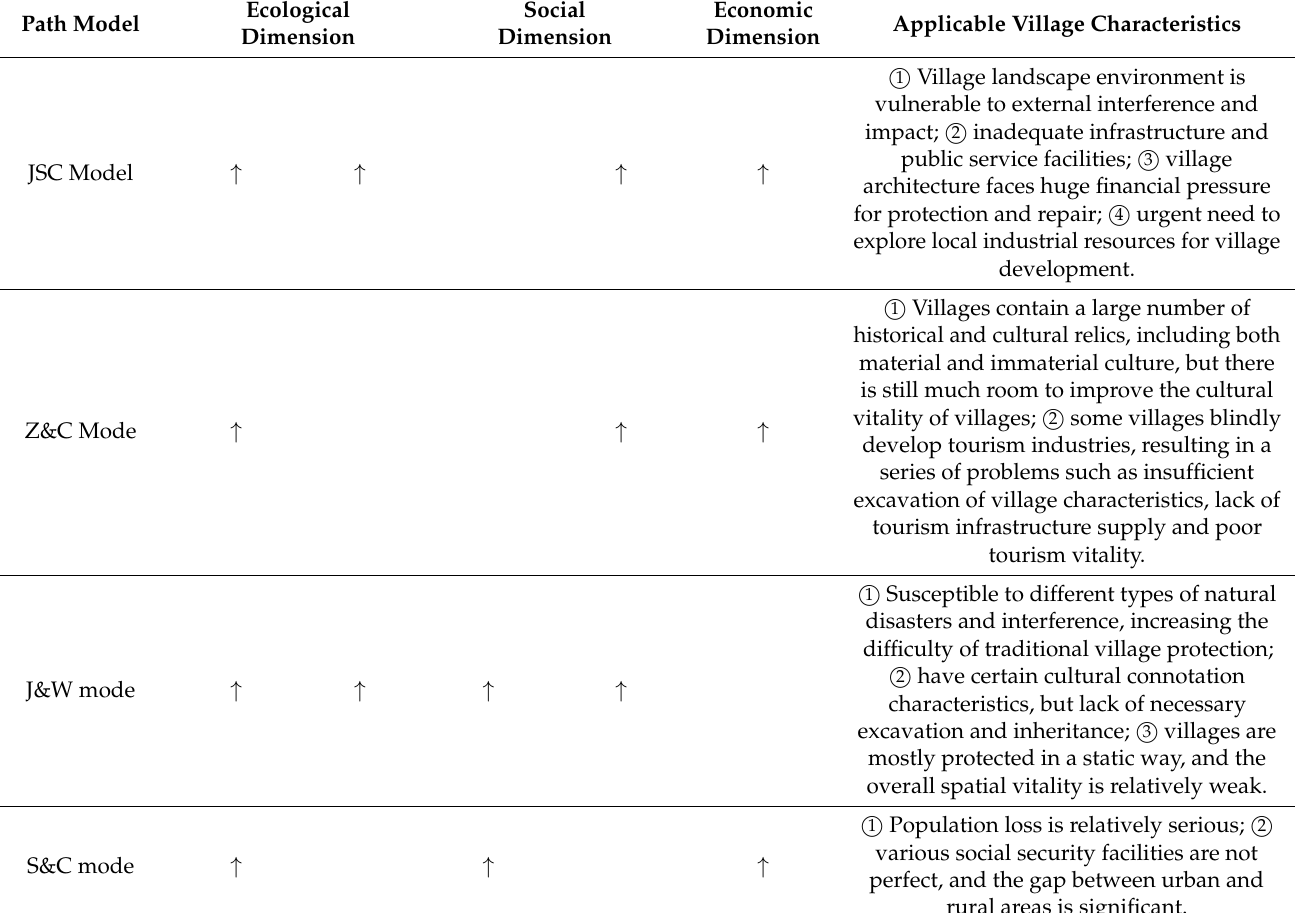
Table 15. Action mechanism of each path